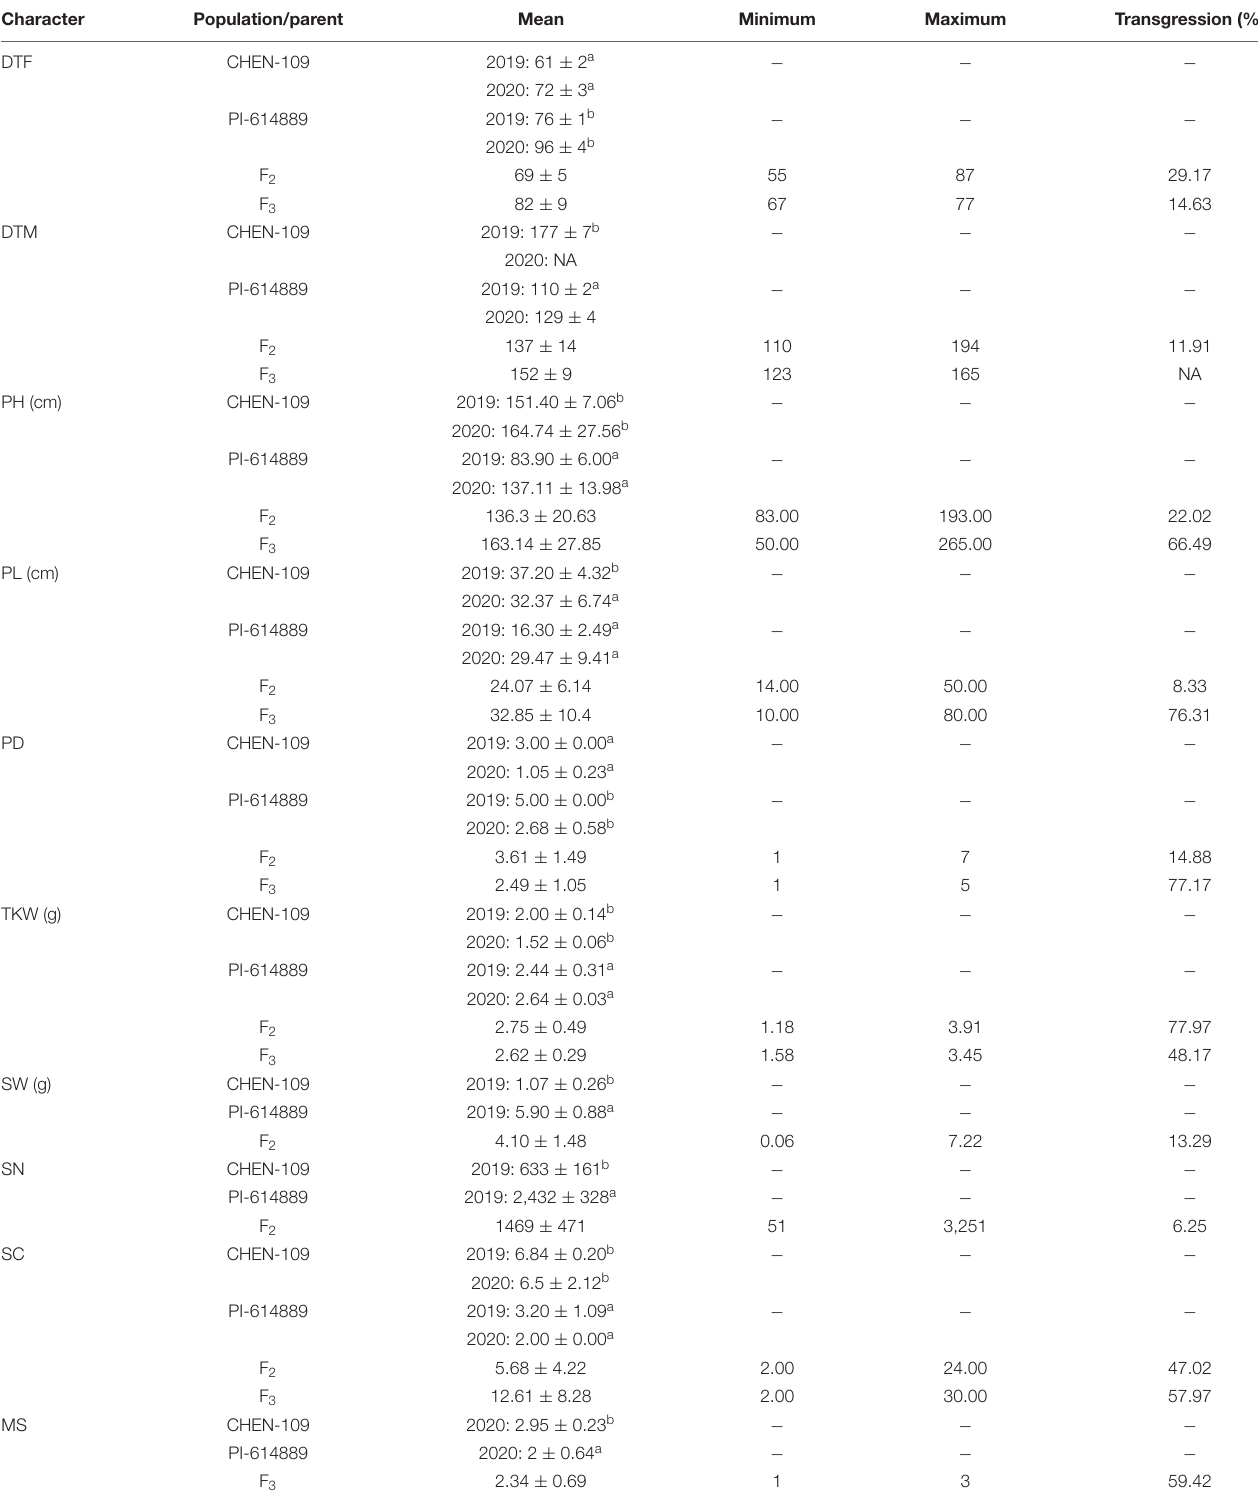
TABLE 1 | Results from the quinoa populations grown in the greenhouse (F 2 ) and the field (F 3 ) and their parental lines. Character Population/parent Mean Minimum Maximum Transgression